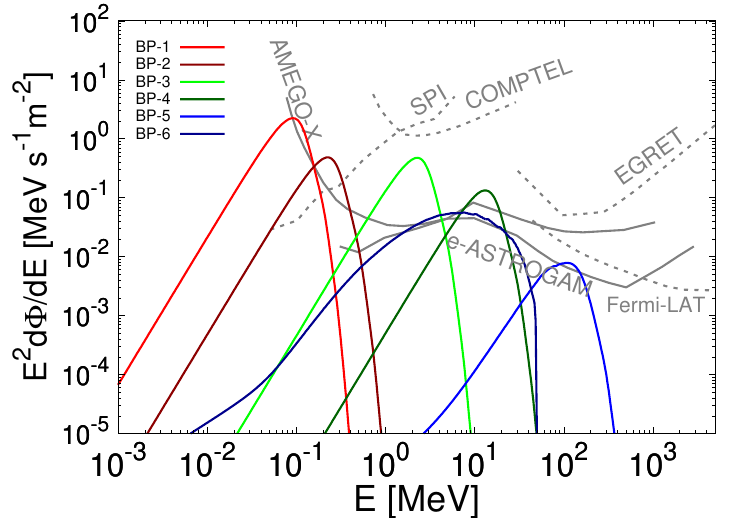
Figure 4 . Extragalactic γ -ray spectra from PBH evaporation for the benchmark points in table 1.